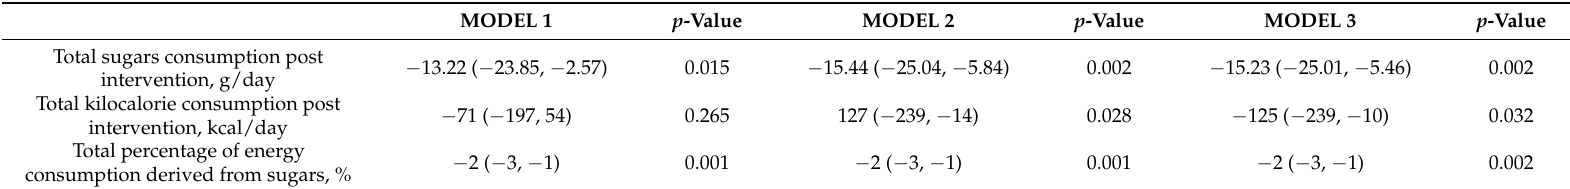
Table 5. Effect of the nutritional intervention on the consumption of total sugars and energy. Linear regression